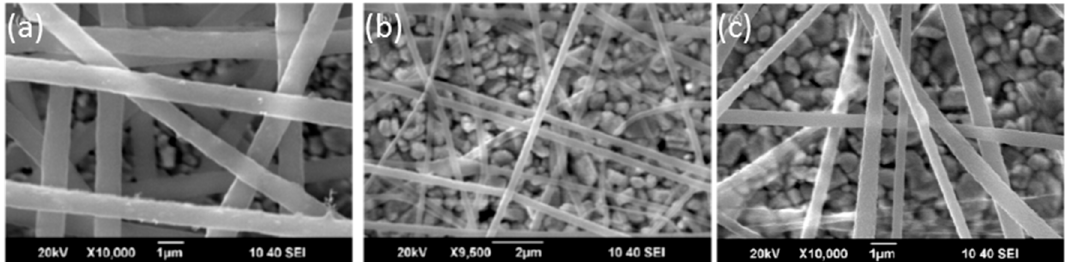
Figure 35. SEM images obtained from sensor heads deposited with Pt-TFPP with 3 different cationic polymers: ( a ) PDDA, ( b ) PEI and ( c ) PAH. A general view of the fibre and a detailed area of the coating is displayed for each coating. Reprinted from [165] with permission from Elsevier.